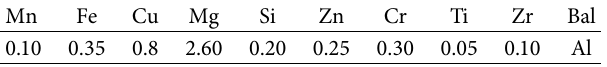
Table 1: Chemical composition of Al